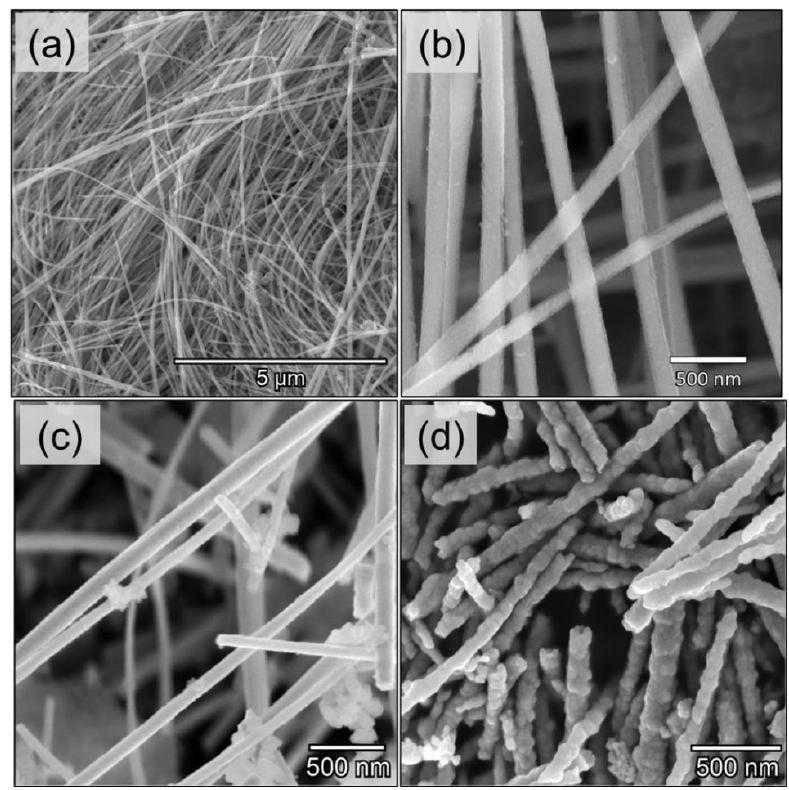
Figure 2. ( a ) SEM and ( b ) HR-SEM images of the as-obtained samples. HR-SEM images of the sam- ples annealed at ( c ) 205 °C and ( d ) 450 °C. samples annealed at ( c ) 205 ◦ C and ( d ) 450 ◦